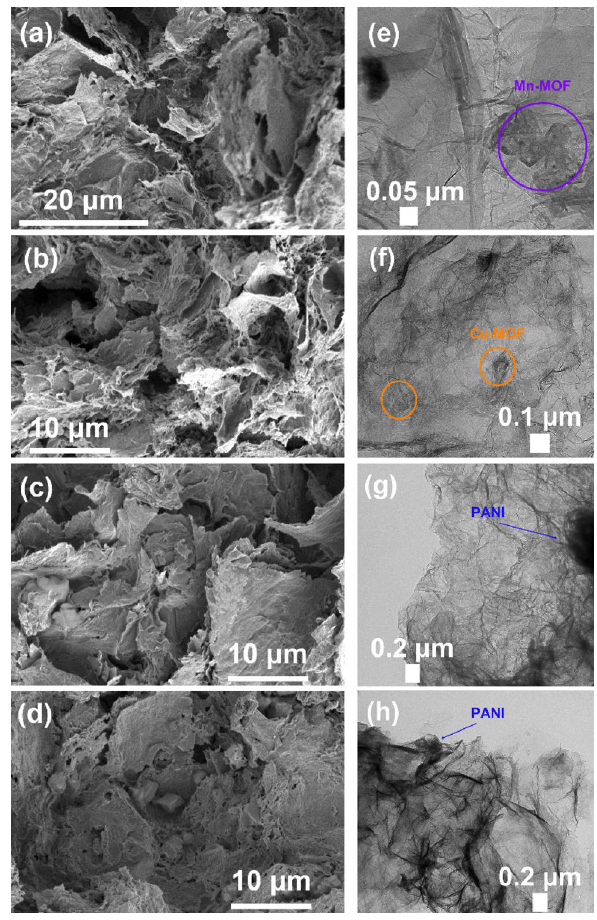
Figure 4. SEM images of ( a ) M1; ( b ) M2; ( c ) M1P and ( d ) M2P; TEM images of ( e ) M1; ( f ) M2; ( g ) M1P and ( h )